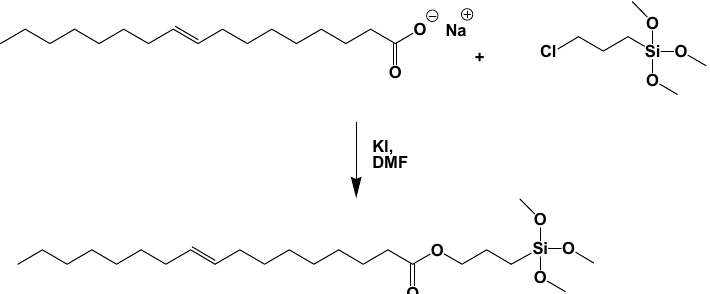
Figure 17. Scheme reaction of the synthesis of rapeseed-based silane. Adapted from [69], with permission from Springer Nature and Copyright Clearance Center, 2018.